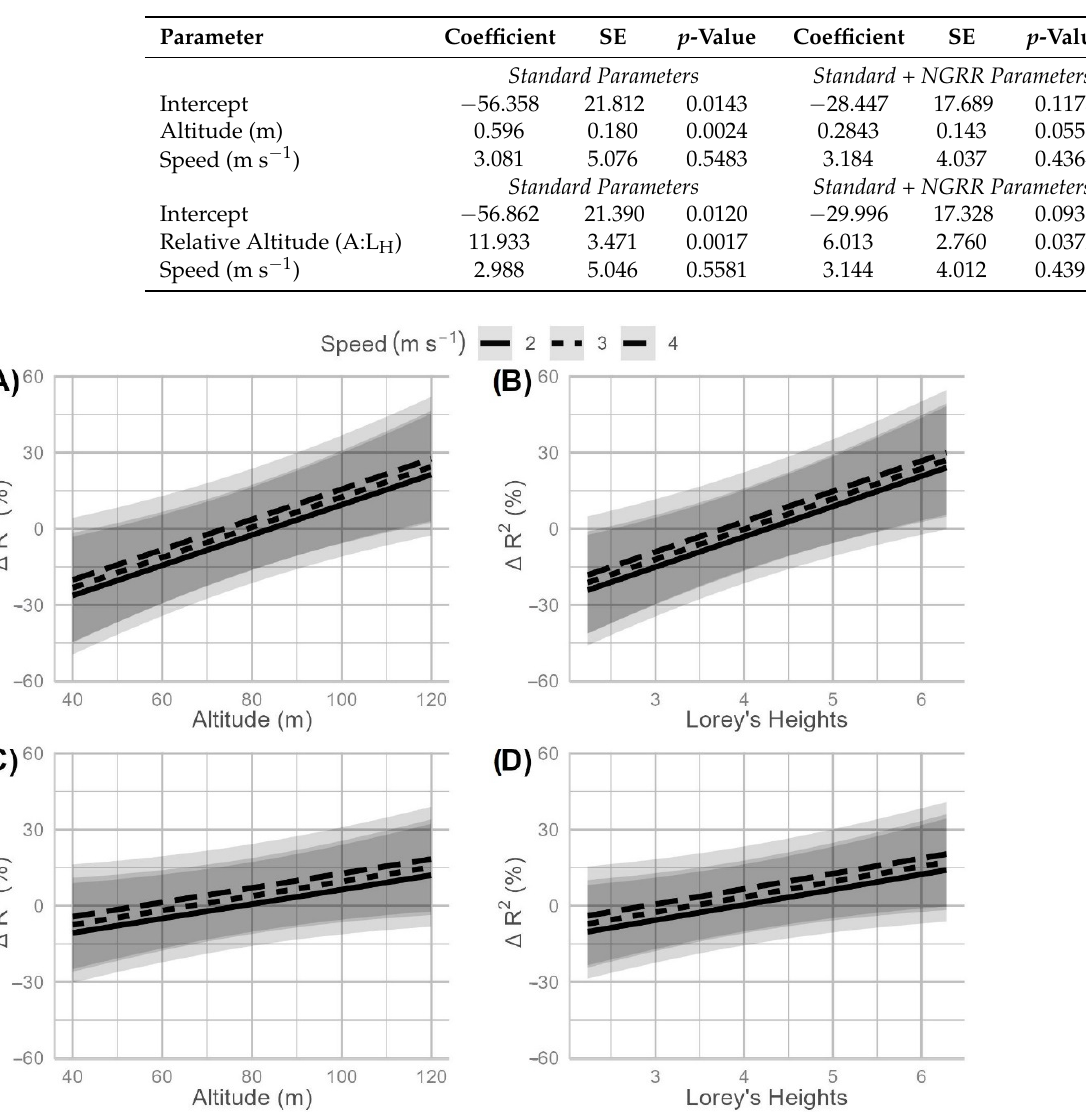
Table 2. Linear mixed-effects model of flight altitude and speed influence the change in aboveground biomass model R 2 ( ∆ R 2 ). A total of four models were created for combinations of the 37 Standard or 37 Standard + NGRR predictions with altitude or relative altitude as predictors; the five study sites were treated as a random effect.